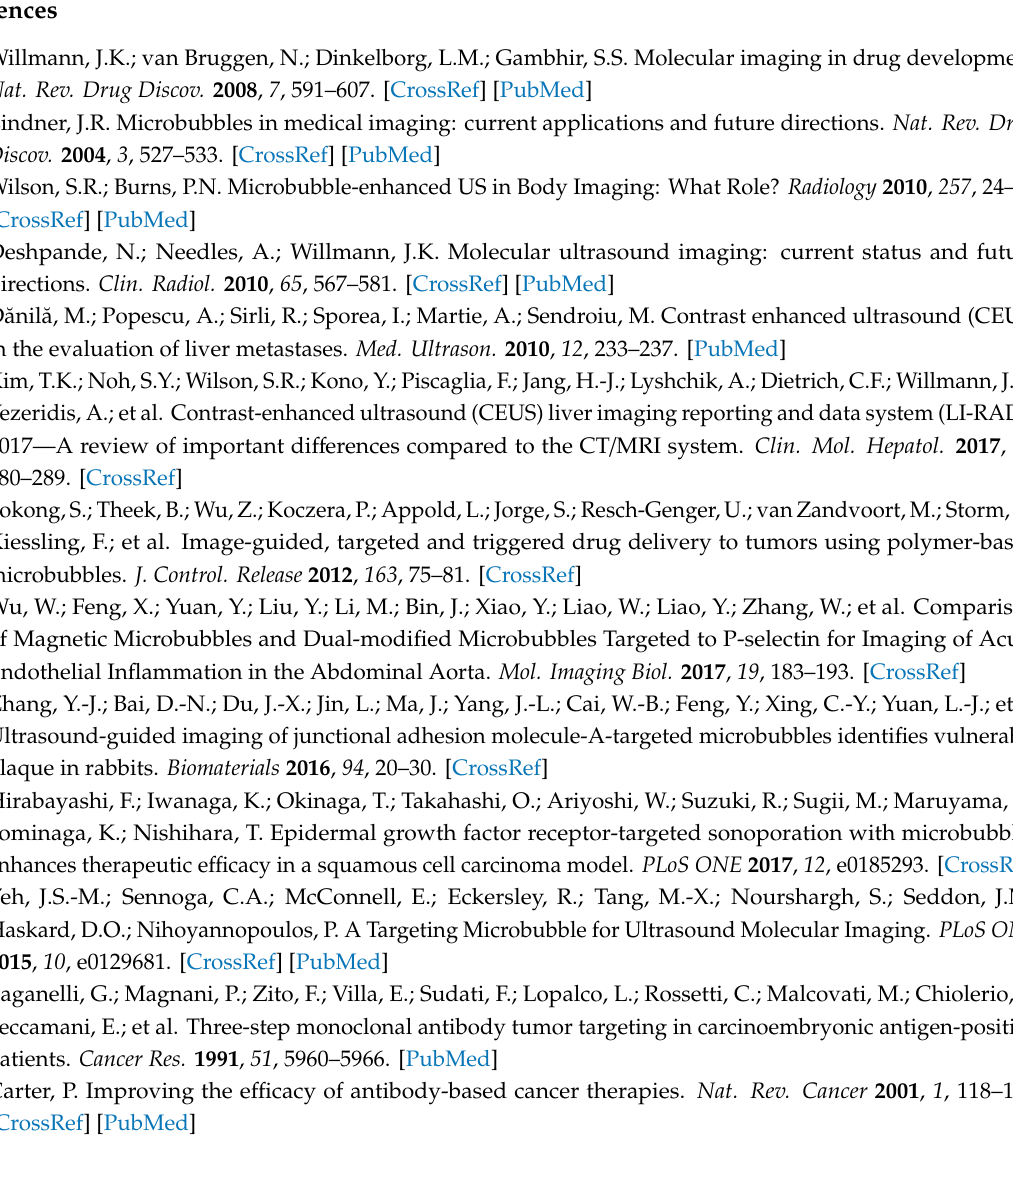
Table S1: Primer sets. Figure S1: SDS-PAGE analysis of purified mouse CD146 antibody (A) and 4D5-Fc antibody (B). Figure S2: ELISA using the Fc-binding polypeptide demonstrates binding to the human IgG1 Fc. Figure S3: Size distribution of liposomes (A) and NBs (B). Figure S4: Specific attachment of anti-HER2 antibody-modified NBs to SKOV3 cells. Figure S5: Cellular uptake of antibody-modified liposomes (Lips) in HUVECs (A) and SKOV3 cells